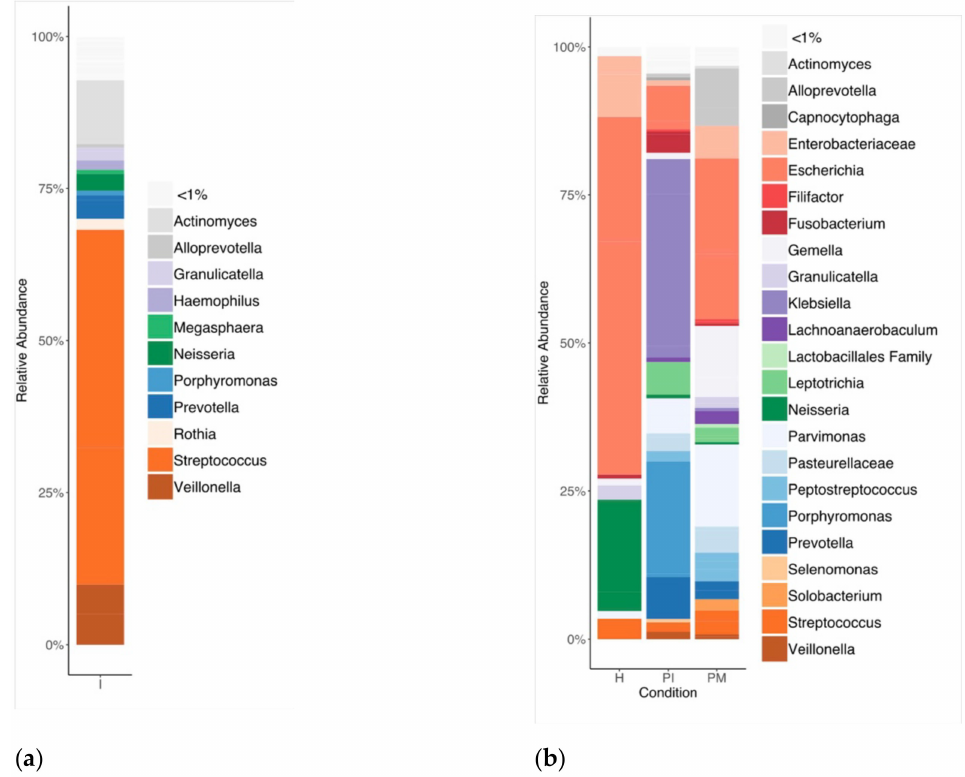
Figure 1. Identified bacteria genera and their relative abundances (% of total bacteria) by 16S rRNA sequencing (V5–V7). ( a ) Inoculum (I), ( b ) steady-state biofilms: peri-implant health (PH), peri-implant mucositis (PM) and peri-implantitis (PI).